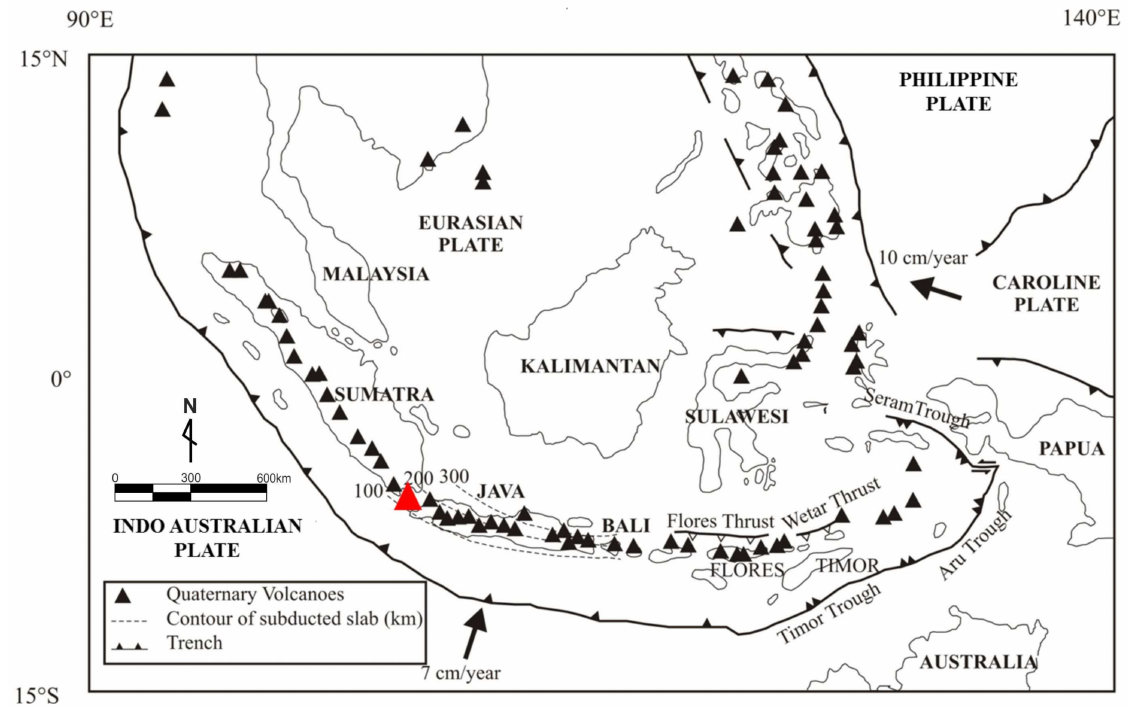
Figure 1. Tectonic map of Indonesia showing the interaction of 3 major plates, modified from [15]. Red triangle depicts Krakatoa Volcano. Contour of subducted slab is taken from